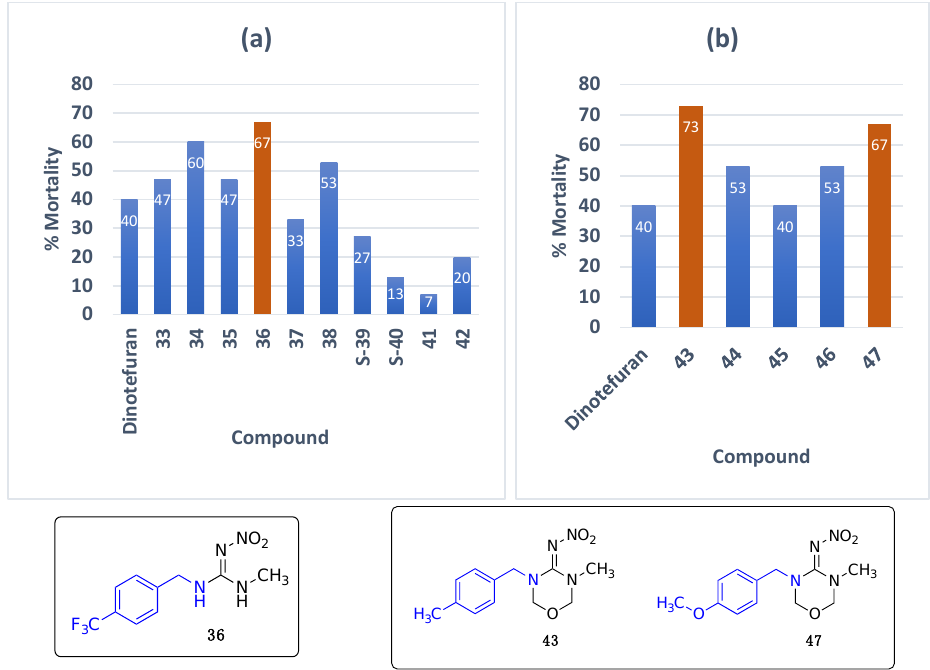
Figure 4. Analysis of ( a ) non-cyclic nitroguanidines; ( b ) cyclic and N -methylated nitroguanidines.